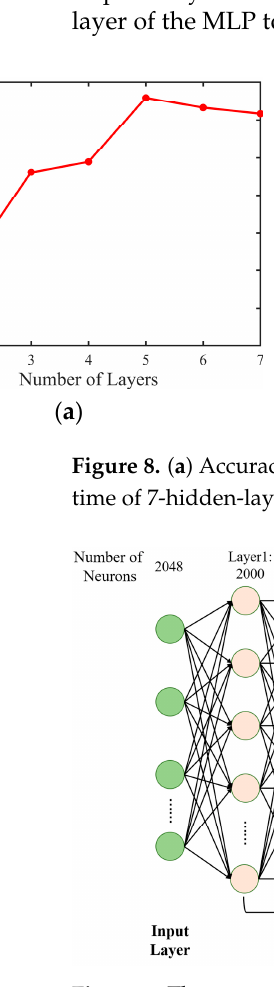
Figure 9. The structure of the proposed multilayer perceptron.